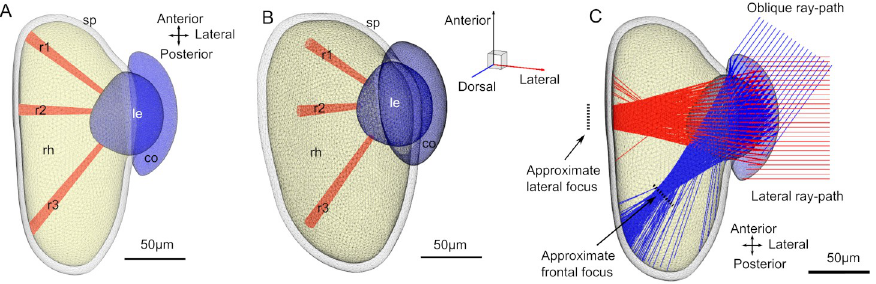
Fig 4. 3D reconstruction of the eye and ray paths. Each volume in the eye is limited by a triangular mesh surface. (A) Top down view of the eye. Each receptor is represented by a unique volume. Three selected receptors (r1, r2 and r3) are plotted to illustrate their size and position. (B) Orthographic side view of the eye to illustrate the 3D volume. (C) A reduced raytracing with two sources (only ~400rays) illustrates the difference of focal point for different incident angles. Rays from the lateral part of the visual field (red) are under-focused, whereas rays from the more frontal direction (blue) are focused inside the retina.